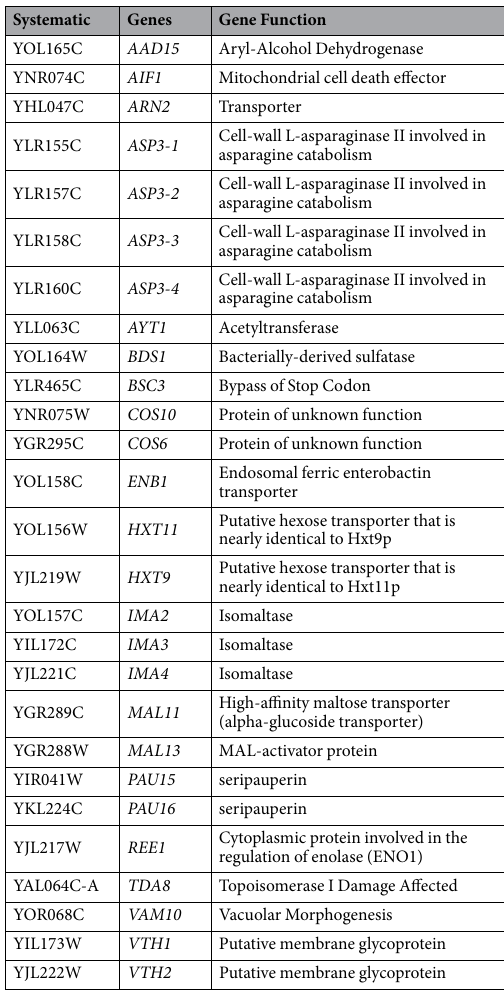
Table 2. Absent genes in Sb - biocodex and Sb - unique28 .